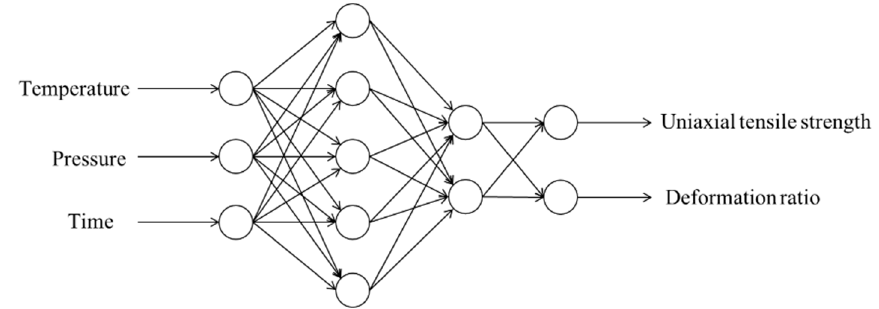
Figure 4. 3-5-2-2 structure of the deep neural network model.